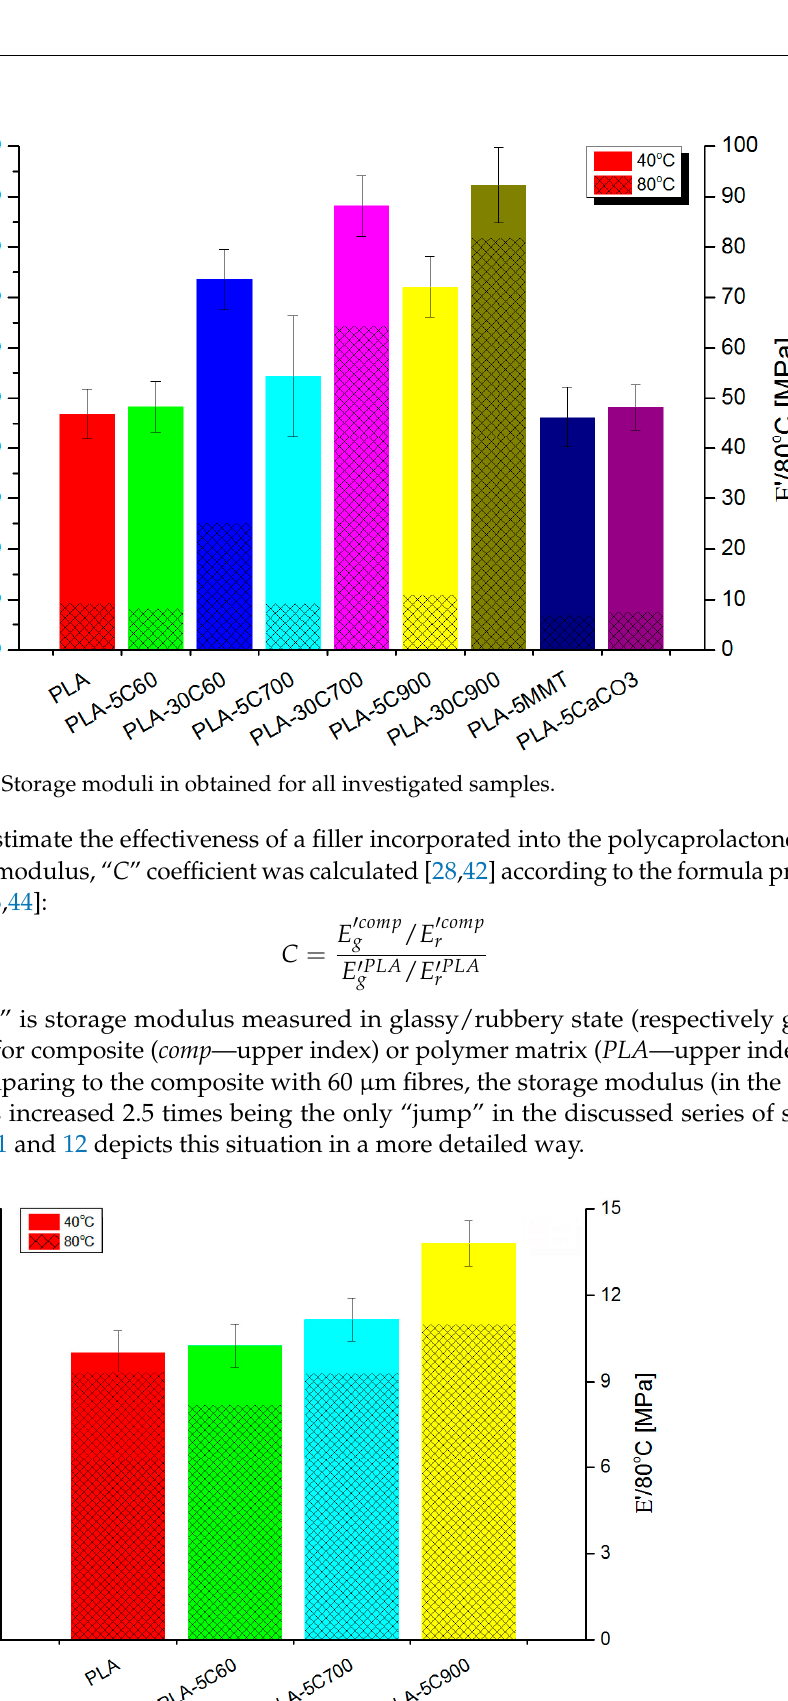
Figure 12. Storage modulus for highly—loaded cellulose fibre reinforced composites.